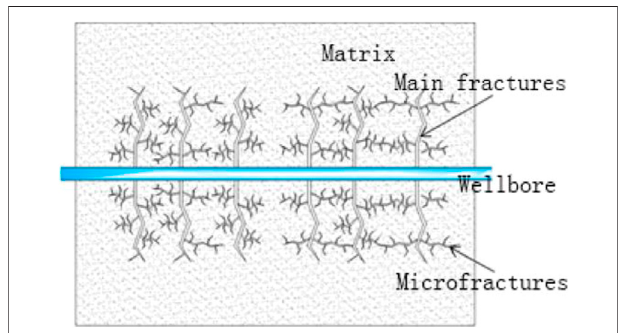
FIGURE 3 | The schematic diagram of multi-media in the arti fi cial fracturing